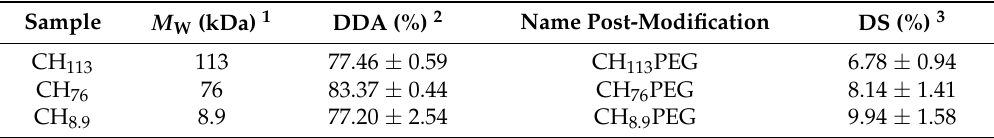
Table 1. Molecular weight, degree of deacetylation, and degree of substitution of CH XX or CH XX PEG samples used in this